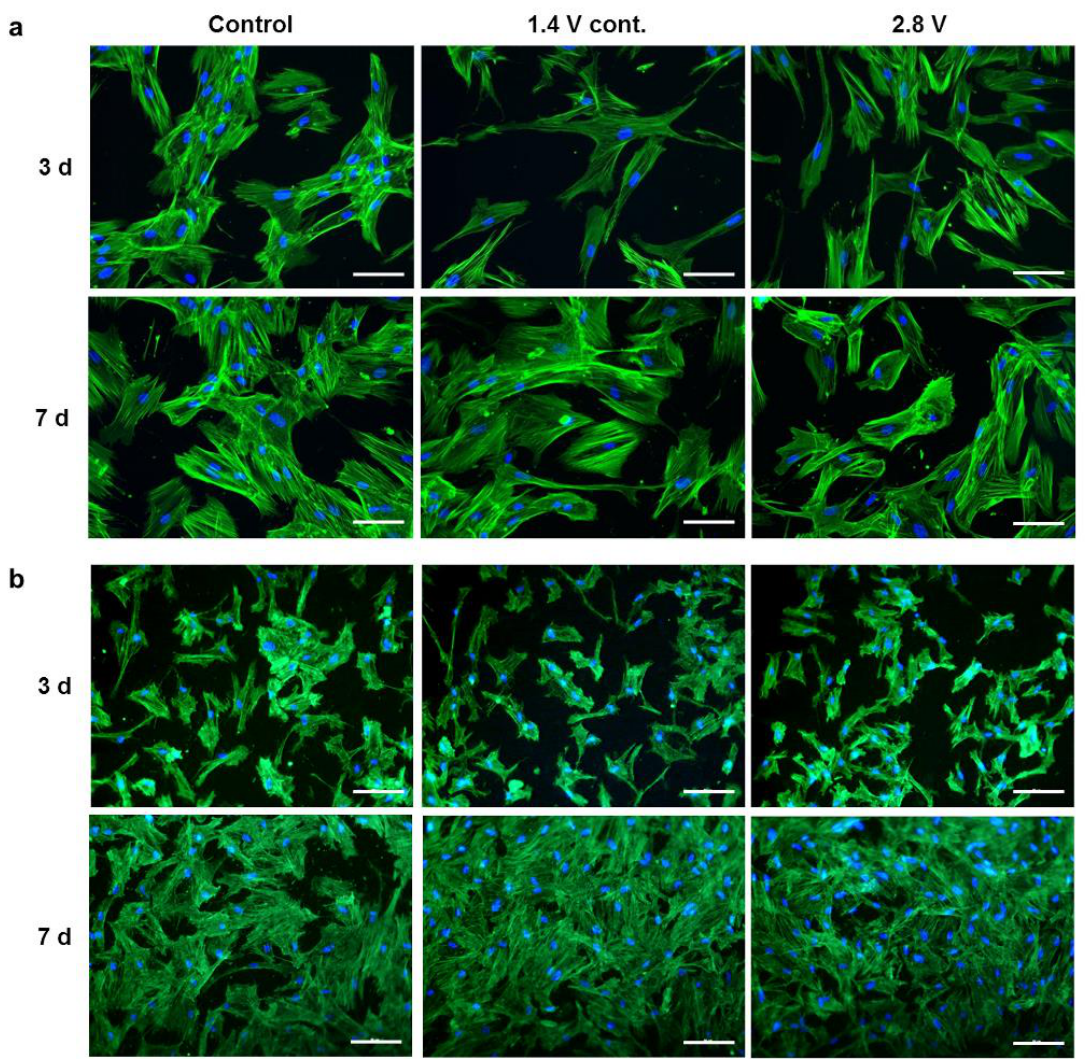
Figure 1. Actin staining of human osteoblasts on collagen-coated coverslips ( a ) and Ti6Al4V electrodes ( b ) in unstimulated cells, after electrical stimulation (ES) with 1.4 V cont. and 2.8 V after three and seven days. The 2.8 V group was stimulated 3 x 45 min per day, while the 1.4 V cont. group was stimulated continuously with 1.4 V. The scale measures 50 µm.